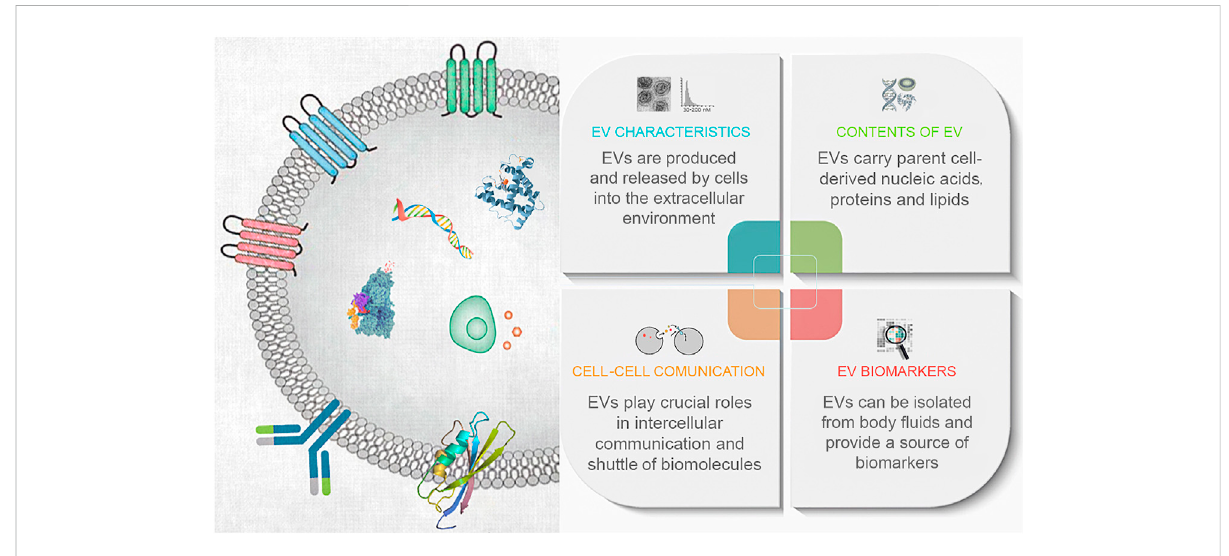
FIGURE 1 An infographic overview of extracellular